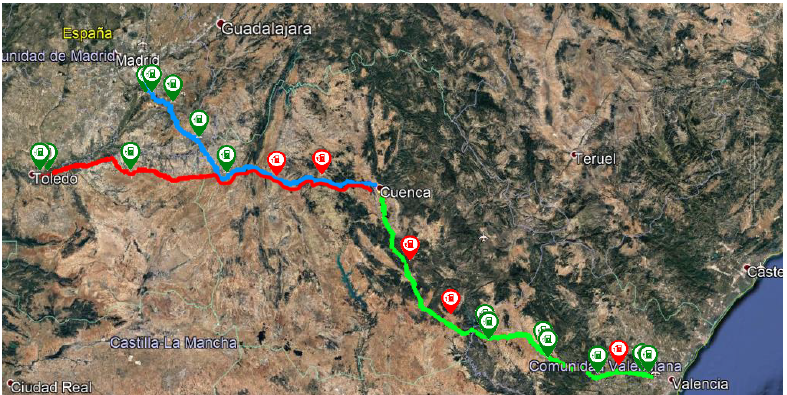
Figure 11. Charging stations on the routes starting from Cuenca: actual (green labels) and suggested (red